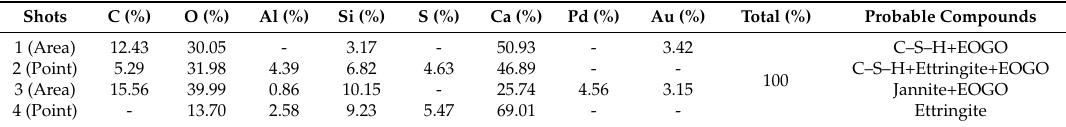
Table 6. Energy Dispersive Spectroscopy (EDS) analysis on EOGO nanoflake-cement composite.